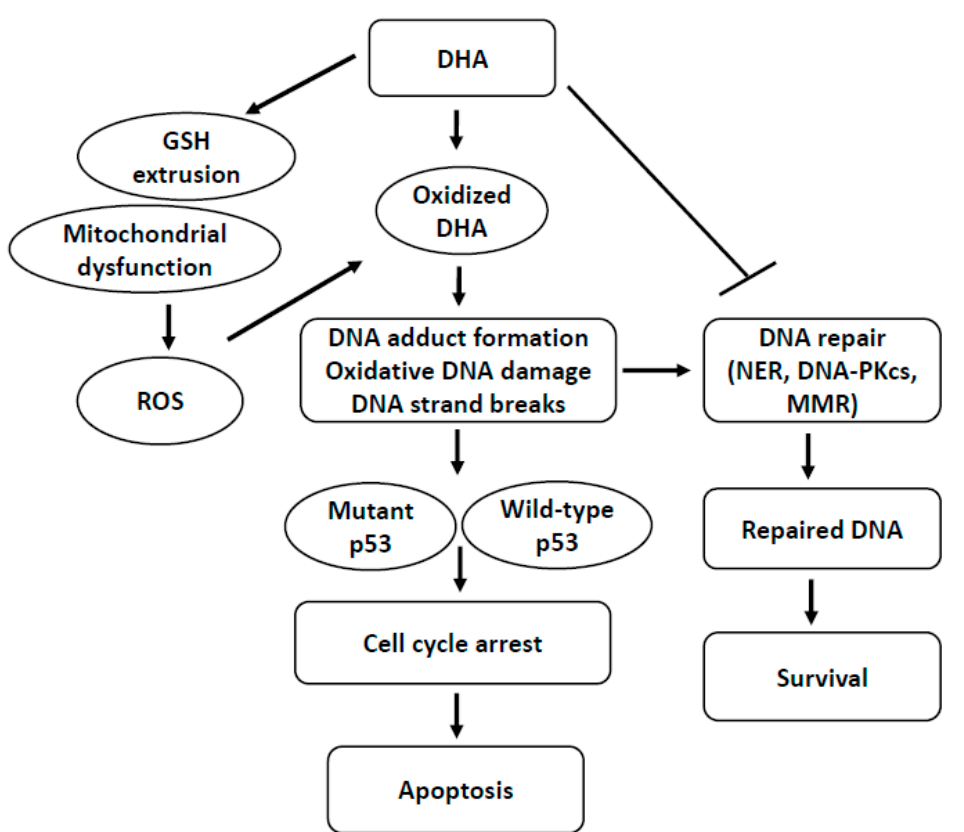
Figure 1. Proposed mechanism of docosahexaenoic acid (DHA)-induced DNA damage response in human cancer cells. DHA initially induces glutathione (GSH) extrusion and mitochondrial dysfunction, which increases reactive oxygen species (ROS) in cancer cells. DHA is oxidized, leading to DNA adduct formation and oxidative DNA damage which triggers cell cycle arrest and apoptosis in p53-dependent and p53-independent pathways. DNA damage is repaired by DNA repair processes such as nucleotide excision repair (NER), mismatch repair (MMR), and non-homologous end joining (NHEJ) mediated by DNA-dependent protein kinase catalytic subunit (DNA-PKcs). After the damaged DNA is repaired, the cells survive. However, excess DNA damage, induced by oxidized DHA, beyond the capacity of the DNA repair processes, initiates apoptotic signaling in cancer cells. Moreover, DHA suppresses the expression of DNA-PKcs and inactivates MMR in some cancer